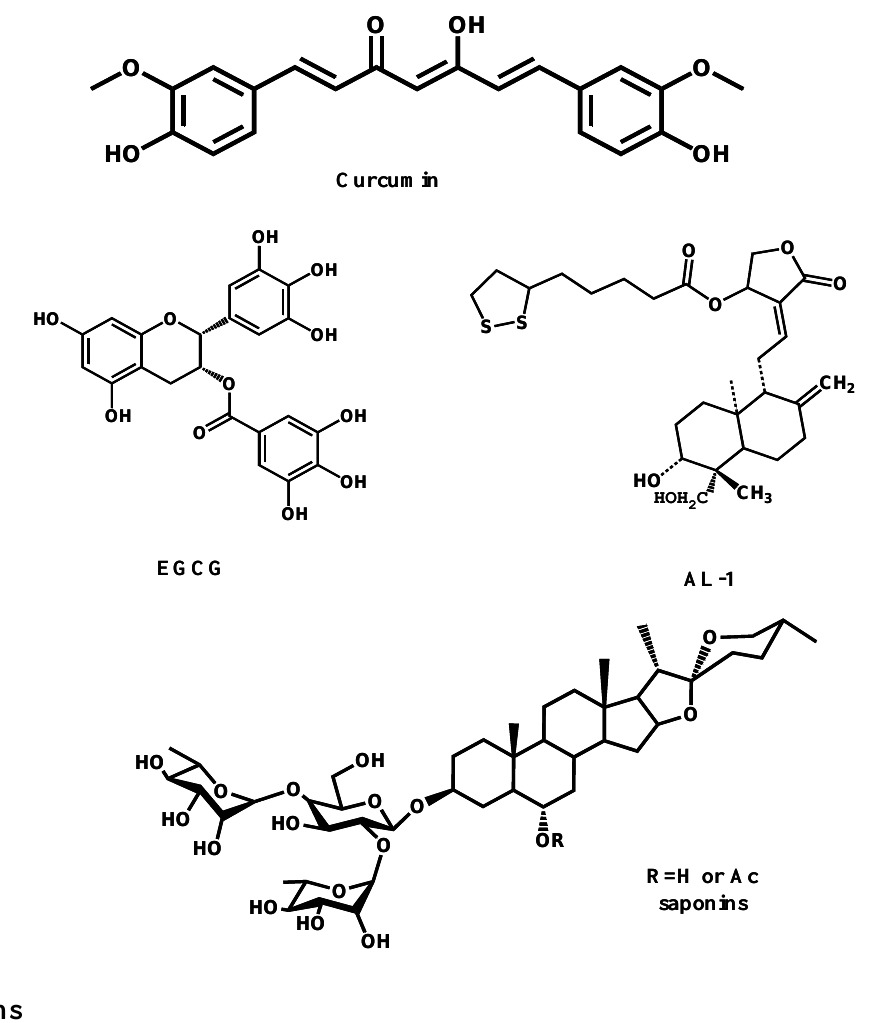
Figure 6. The chemical structures of IAV inhibitors targeting HA1 to block virus binding to